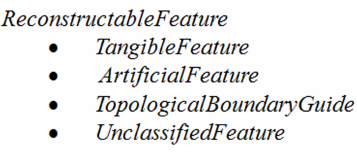
Fig. 3. Four main subcategories of ReconstructableFeature in GPGIM.